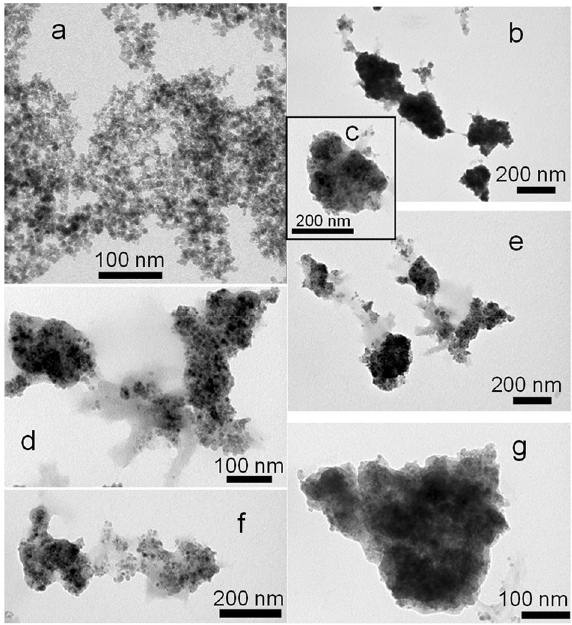
Figure 2. TEM images of ( a ) MNPs of diameter around 5–10 nm. From ( b ) to ( g ) hybrid (Fe 3 O 4 @P(MEO 2 MA) microgels, particle diameter around 150–200